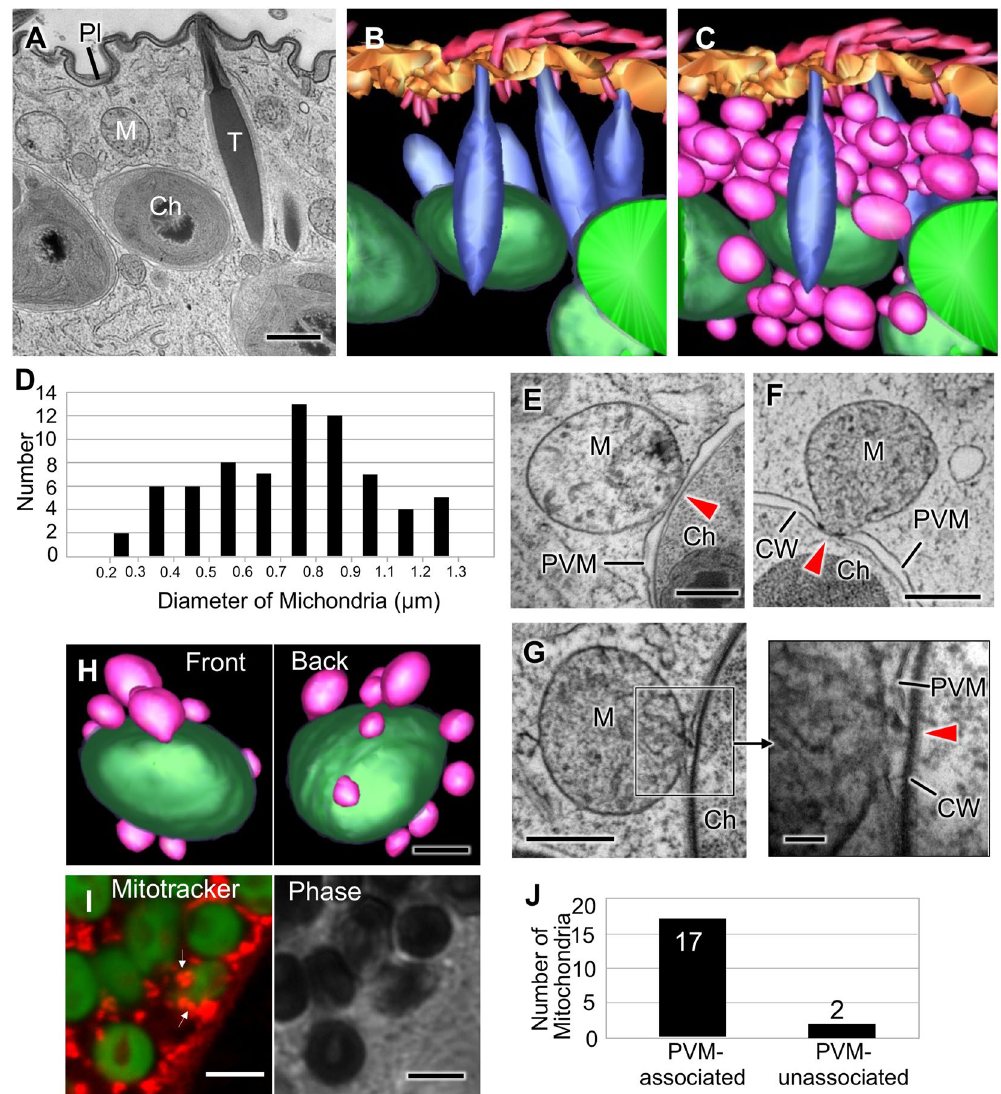
Figure 2. TEM analyses of the associations between P . bursaria mitochondria and symbiotic zoochlorella. ( A ) TEM image of the 31st of 45 serial ultrathin sections of a P . bursaria cell. ( B , C ) A 3-D reconstruction and segmentation of the subcortical region of P . bursaria generated from TEM images of 45 serial ultrathin sections with and without mitochondria, respectively. Symbiotic zoochlorella are shown in green, trichocysts are shown in blue, and mitochondria are shown in pink. ( D ) The distribution of mitochondrial diameters in the 3-D reconstruction. ( E ) TEM image of a mitochondrion attached to the PVM surrounding a zoochlorella cell. The arrowhead indicates the contacted area. ( F ) TEM image of a mitochondrion connected to the cell wall of a symbiotic zoochlorella. The arrowhead indicates the connecting area. ( G ) TEM image of the interconnecting bridge (arrowhead) between a mitochondrion and the cell wall of a zoochlorella cell. ( H ) A 3-D model of zoochlorella-associated mitochondria. ( I ) Fluorescence microscopy image of autofluorescencing zoochlorella cells (green) and MitoTraker Red-stained mitochondria (red) in P . bursaria . The arrows indicate the host mitochondria (shown in red) associated with symbiotic zoochlorella (shown in green). A corresponding phase contrast image is shown in the right panel. ( J ) The number of PVM-associated and -unassociated mitochondria within distance of 20 nm from the PVM in 3D model of Fig. 2C. Scale bars: 1 μ m ( A , H ), 500 nm ( E – G ), 100 nm (inset in G ), and 5 μ m ( I ). Ch, zoochlorella; CW, cell wall; Pl, plasma membrane; M, mitochondrion; PVM, perialgal vacuole membrane; T,